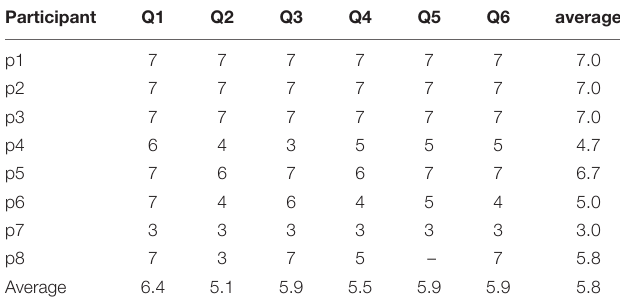
TABLE 4 | Laryngectomees’ short evaluation of their beatboxing